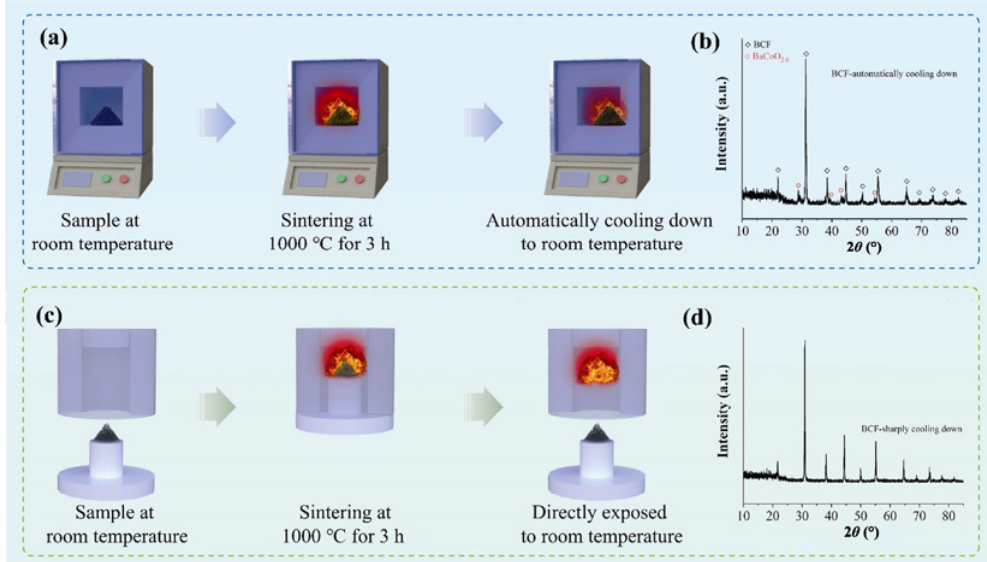
Fig. 1 (a) Scheme for synthesizing BCF powders with the conventional calcination procedure and (b) the corresponding XRD pattern after firing; (c) scheme for synthesizing BCF powders using the calcination process involving a rapid cooling procedure and (d) the corresponding XRD pattern after firing.